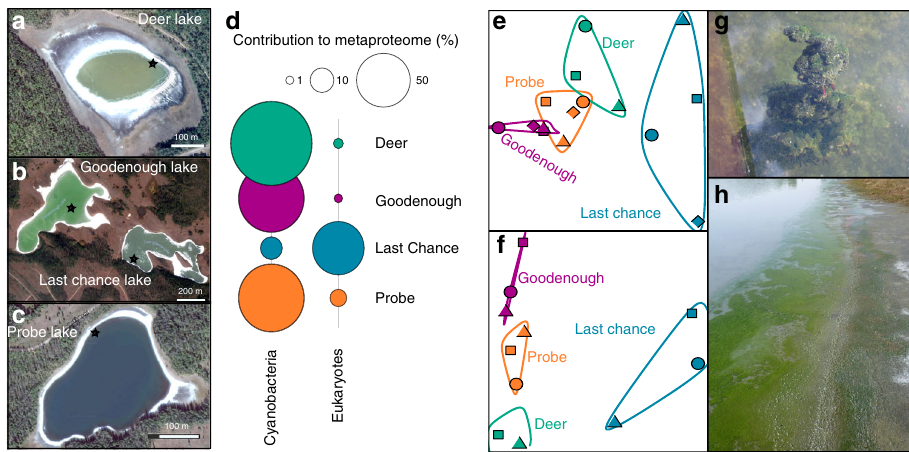
Fig. 1 Images and biological description of Cariboo Plateau soda lakes. Google Satellite images of a Deer Lake, b Goodenough and Last Chance Lakes, and c Probe Lake. Black stars indicate approximate sampling locations. d Bubble plots showing the relative contribution of Cyanobacteria and Eukaryotes to the lake metaproteomes. e Non-metric multidimensional scaling (NMDS) plots using Bray-Curtis dissimilarity to visualize the microbial communities of the soda lake mats over years of sampling using 16 S rRNA amplicon sequencing data, and f 18 S rRNA amplicon sequencing data. Shapes indicate year of sampling: Circles: 2014, square: 2015, diamond: 2016, triangle: 2017. Samples for 18 S rRNA analysis were not taken in 2016, and Deer Lake samples were not taken in 2014 for 18 S, and 2016 for 16 S. NMDS Stress values were below 0.11. g Image of microbial mat from Goodenough Lake, and h Image of microbial mats along the shore of Last Chance Lake. Map data: Google, Maxar